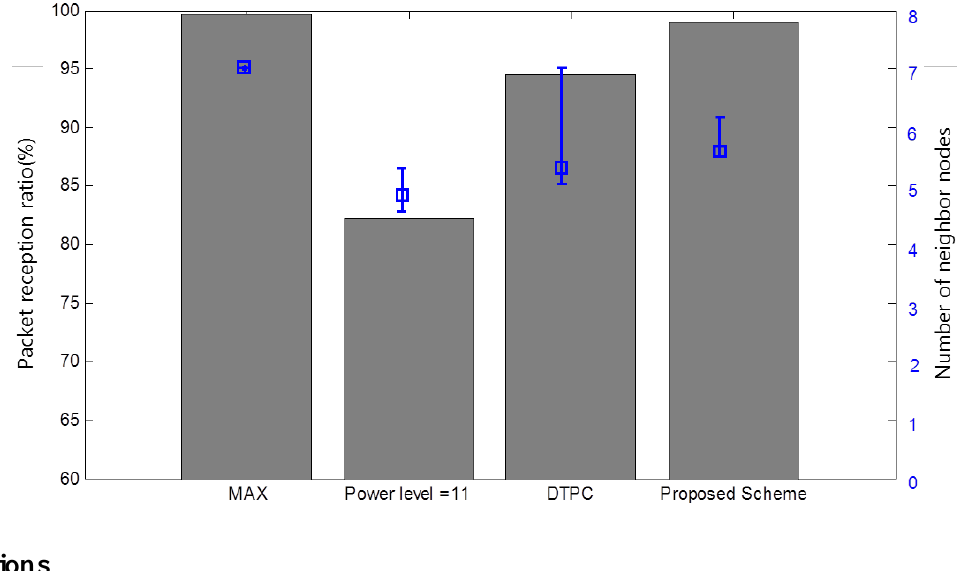
Figure 13. Packet reception